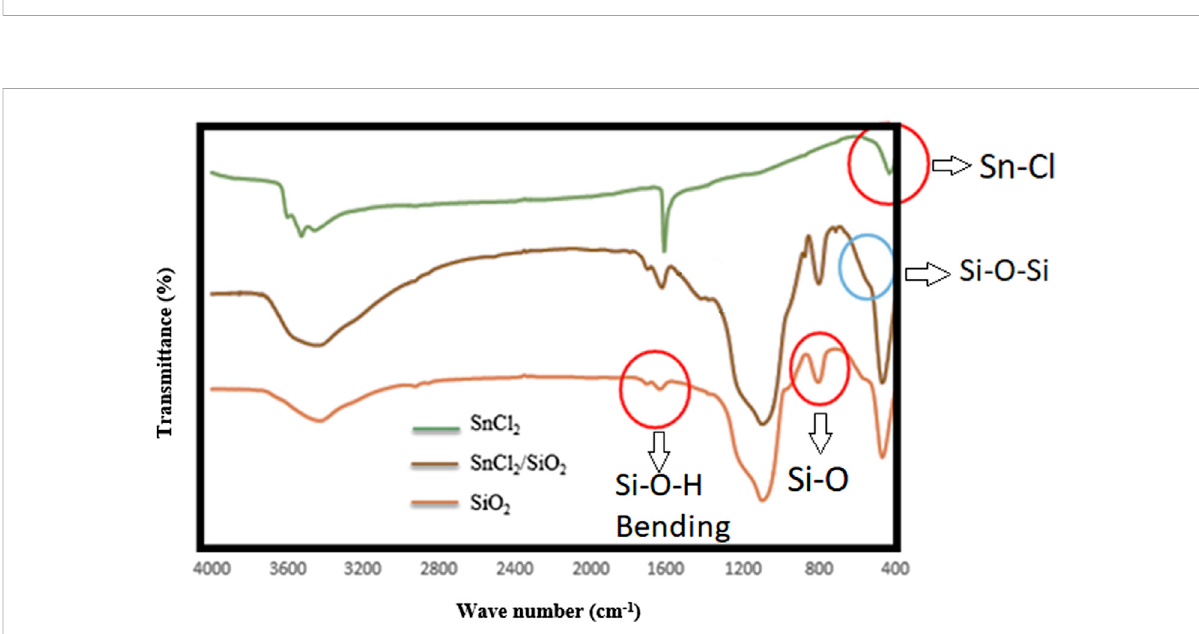
FIGURE 3 XRD pattern of the prepared catalyst (A) compared with nano-silica (B)